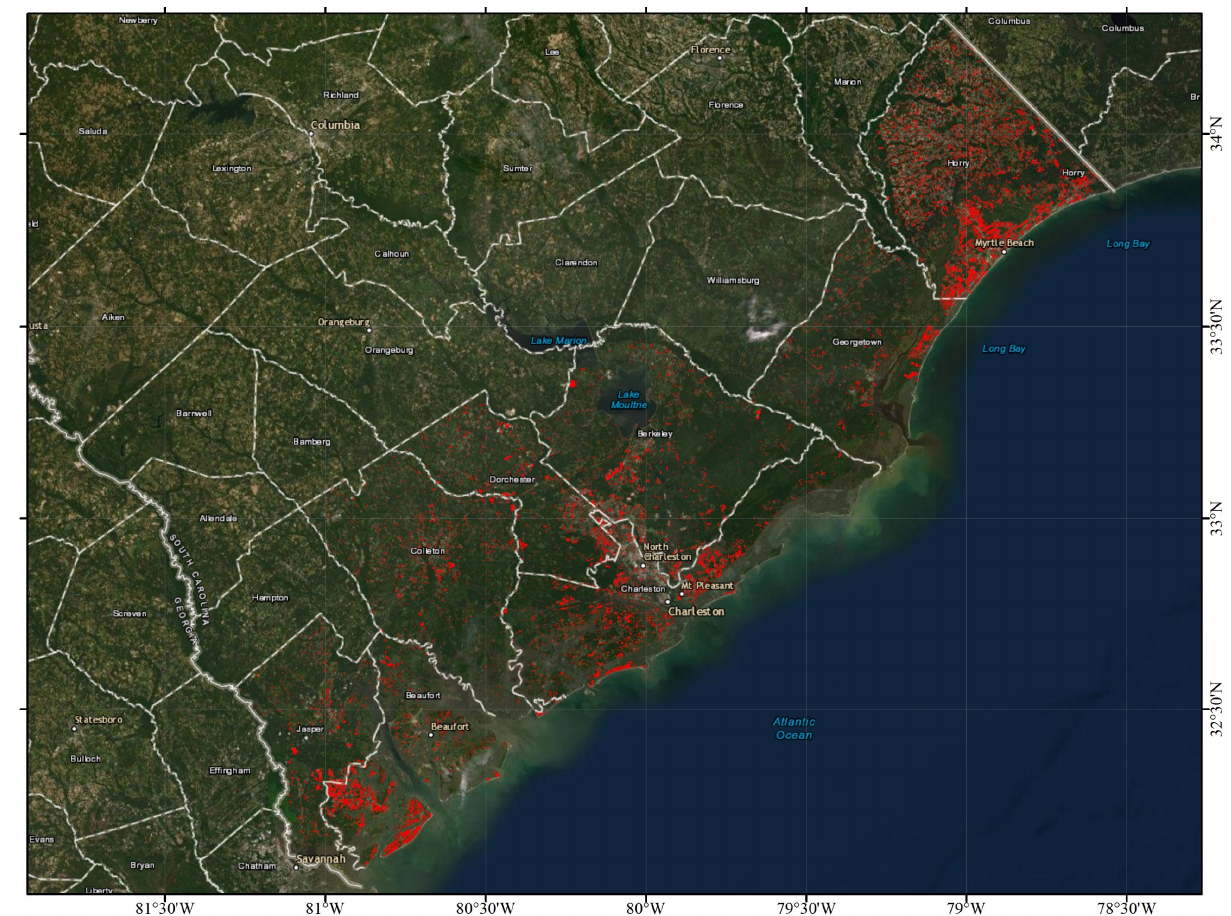
Figure 4. Stormwater management ponds in South Carolina.